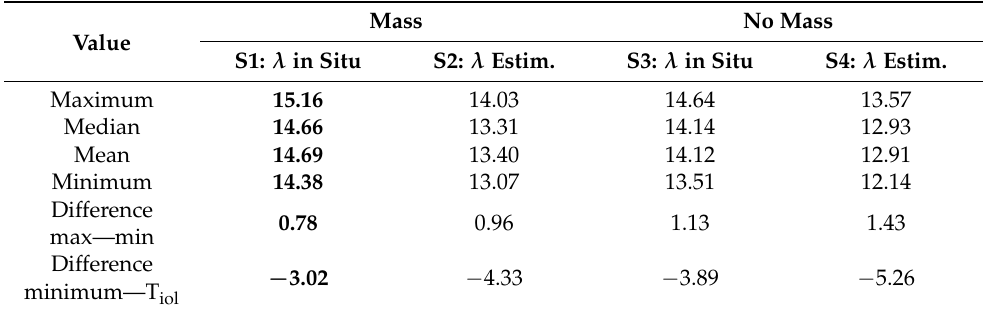
Table 9. Indoor operative temperature values in simulations (8–14 January 2018). No heating devices. In bold: values that would be closer to complying with ASHRAE